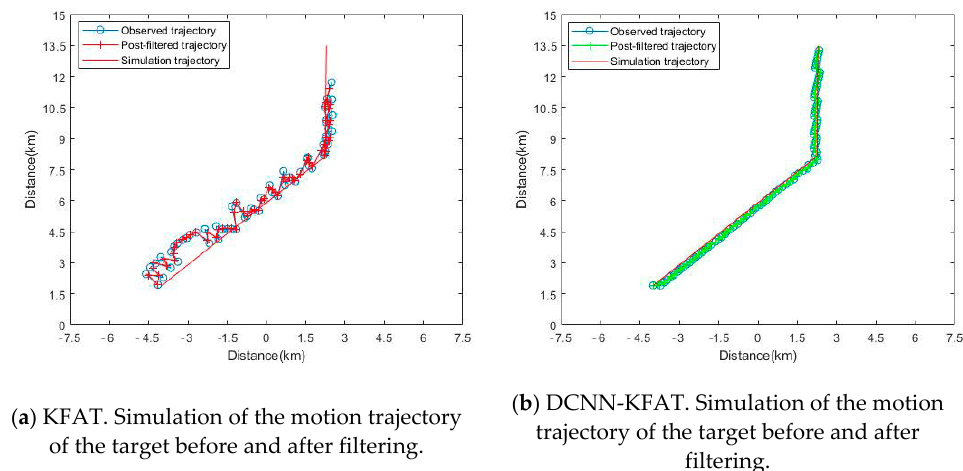
Figure 18. The target SNR gradually decreases and DCNN-KFAT tracks further than KFAT.